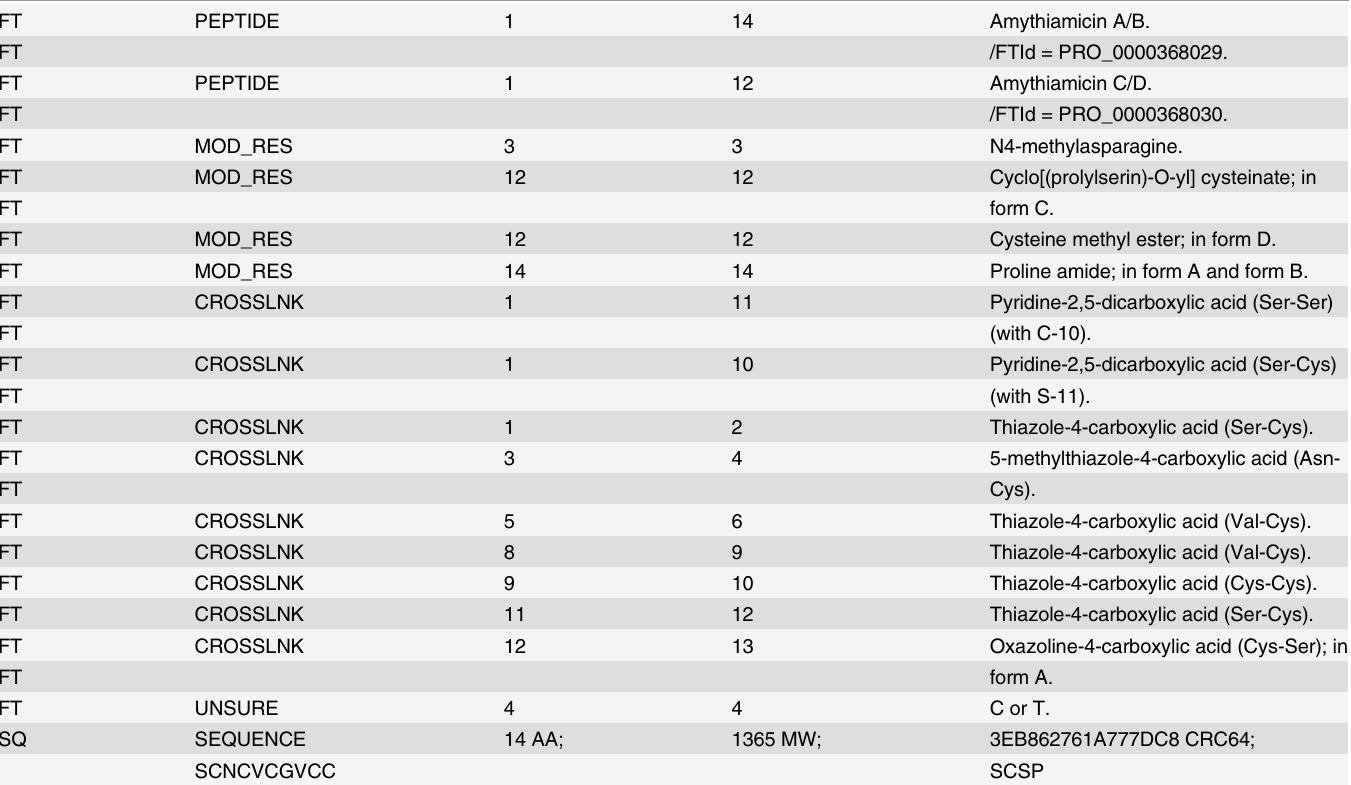
Table 6. Example FT and SQ records from an extracted .fasta